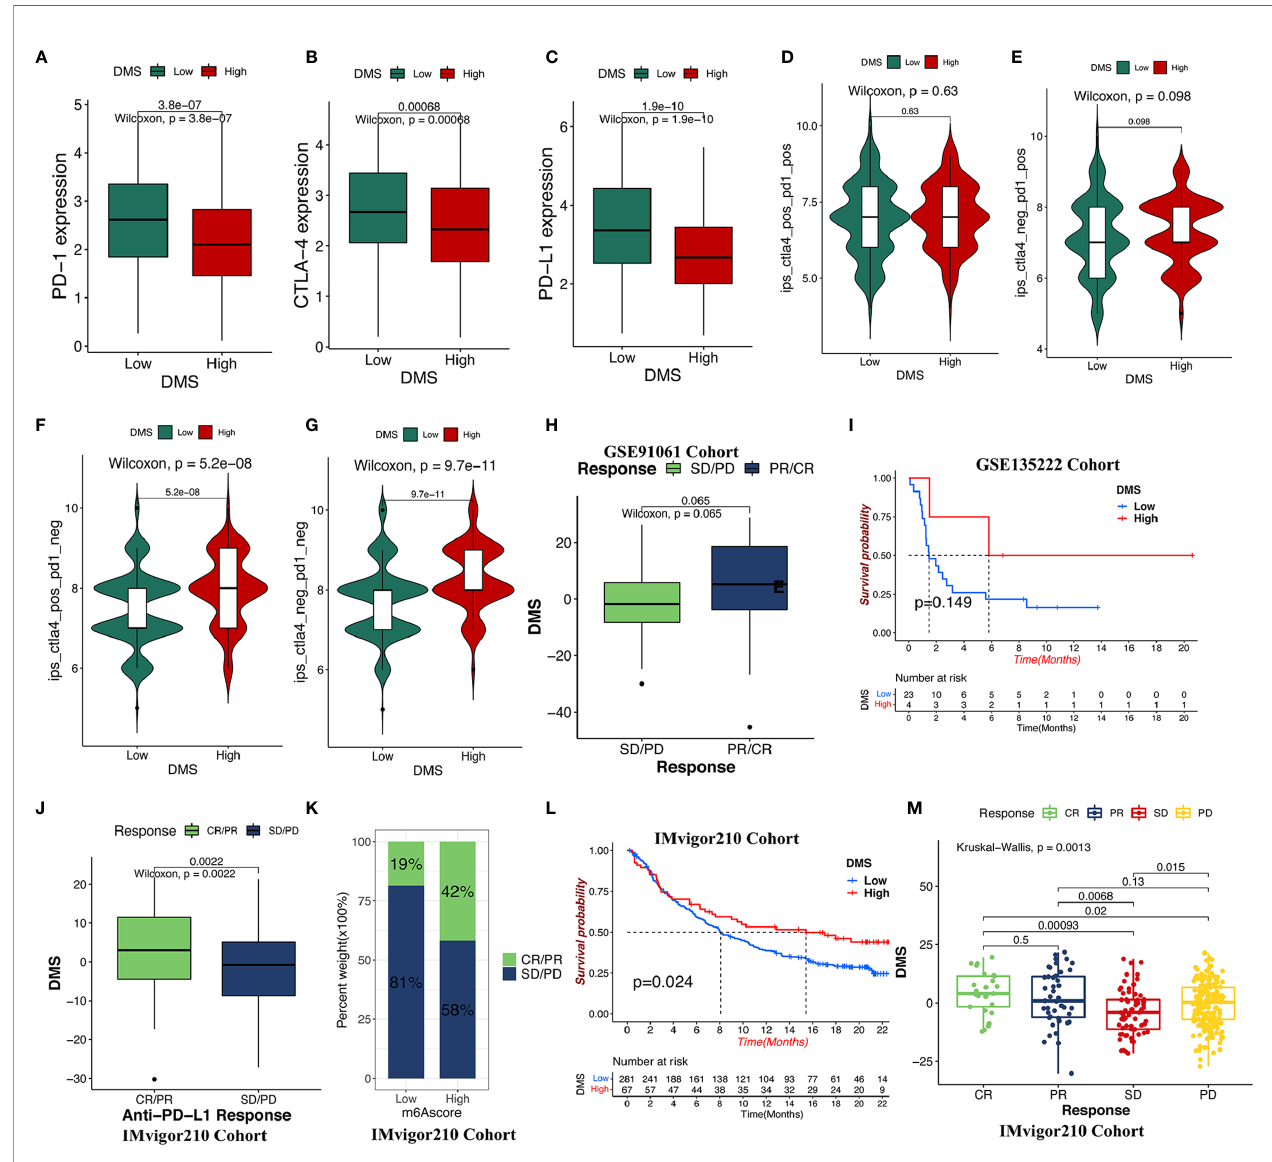
FIGURE 6 | The role of DMS in anti-CTLA-4/PD-1/PD-L1 immune treatment cohort. (A – C) The relative expression of immune checkpoints between high DMS and low DMS in TCGA cohort. (D – G) Immunotherapeutic bene fi ts of anti-CTLA-4/PD-1 treatment in TCGA cohort. (H) Difference in the DMS for anti-CTLA-4/PD-1 clinical responses in the GSE91061 dataset. CR/PR, complete response/partial response; SD/PD, stable disease/progressive disease. (I) Progression-free survival analysis for distinct DMS groups in GSE135222 cohort. (J, K) Difference in the DMS for anti-PD-L1 clinical response in the IMvigor210 cohort. (L) Survival analysis for low- and high-DMS groups in the IMvigor210 cohort. (M) The clinical response of patients treated with anti-PD-L1 according to DMS